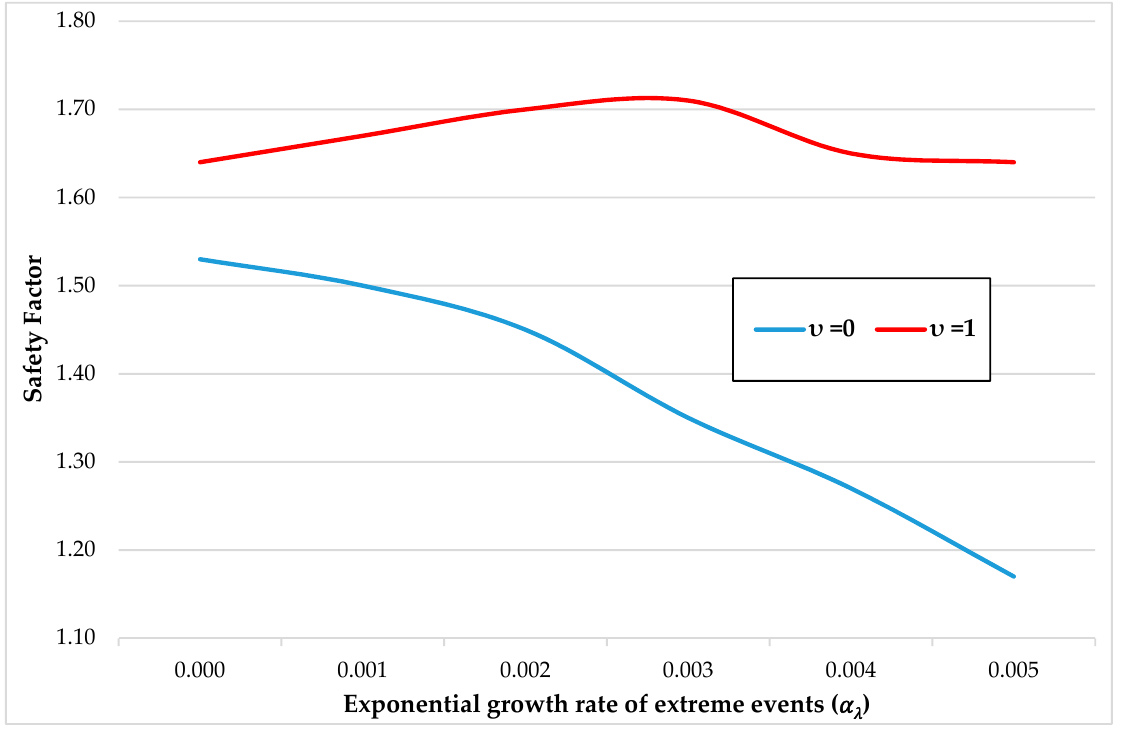
Figure 11. Optimal 𝜺 𝑻 values as a function of growth rate of extreme events. Figure 11. Optimal ε T values as a function of growth rate of extreme